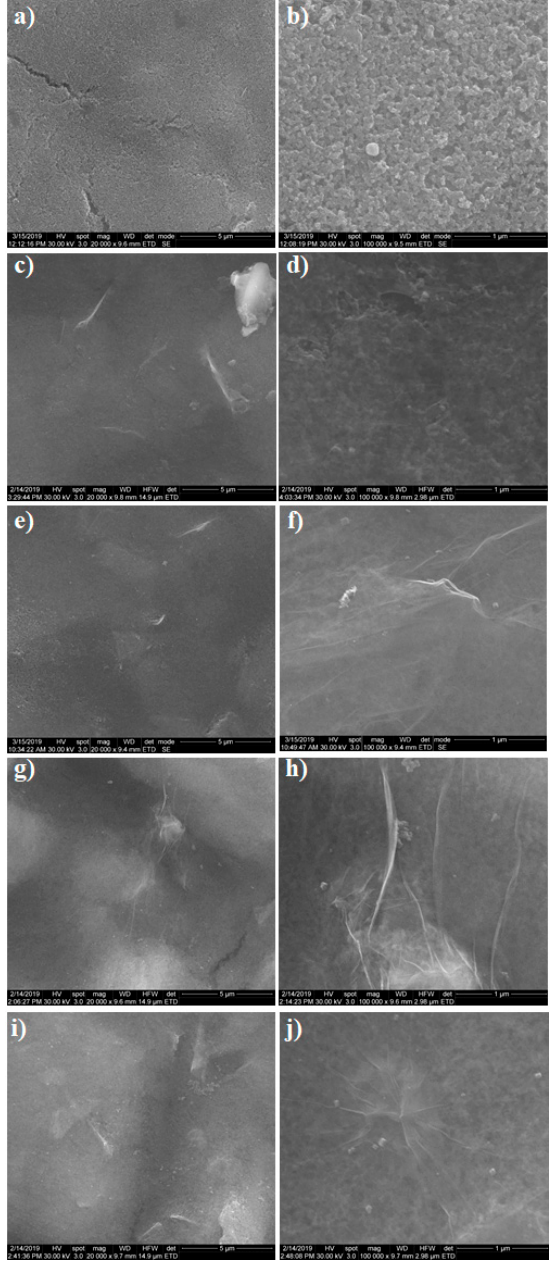
Figure 1. ( a , b ) SEM images of bare screen printed carbon electrode (SPCE). ( c - j ) SEM images of graphene oxide (GO) deposited on SPCE using different dispersion concentrations: ( c , d ) 0.05 mg/mL; ( e , f ) 0.1 mg/mL; ( g , h ) 0.15 mg/mL; and ( i , j ) 0.2 mg/mL. ( a,c,e,g,i ) Images recorded at 20 kX magnification. ( b,d,f,h,j ) Images recorded at 100 kX magnification.